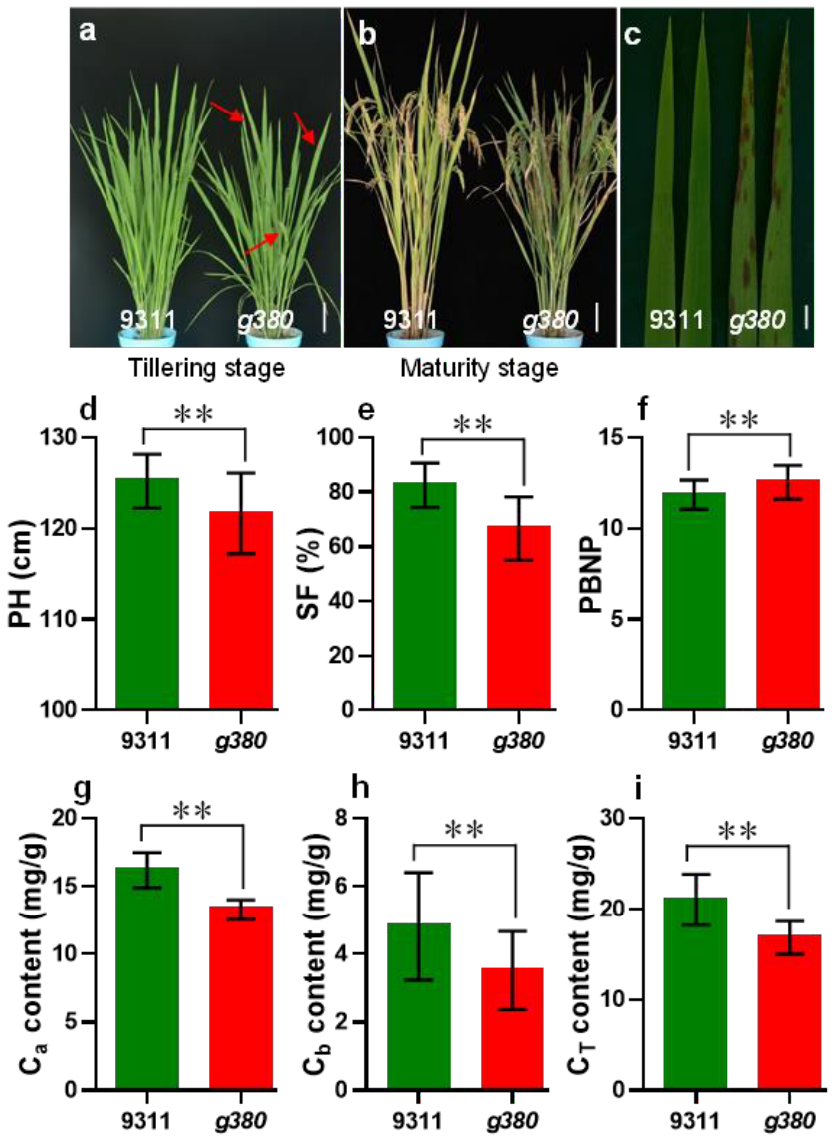
Figure 1. Characterization of the g380 mutant. ( a ) Plants of 9311 and g380 at the tillering stage. ( b ) Plants of 9311 and g380 at the maturity stage. ( c ) Leaves of 9311 and g380 . ( d – f ) Agronomic traits of 9311 and g380 plants. PH, plant height; SF, spikelet fertility; PBNP, primary branch number per panicle. ( g – i ) The chlorophyll content of 9311 and g380 leaves. Bar = 10 cm in ( a ) and ( b ); red arrows point out lesions on g380 leaves in ( a ); bar = 1 cm in ( c ). ** represent p < 0.01 by Welch’s t -test.